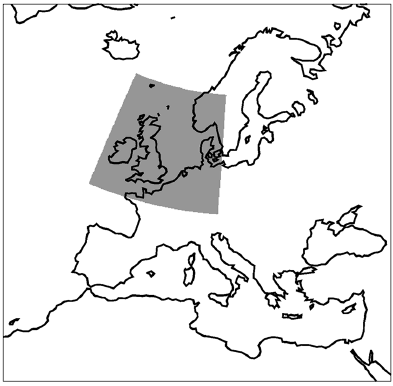
Figure 1. Domain of the storm surge model, CS3 (shaded). The outer frame indicates the domain of the regional atmospheric cli- mate model.